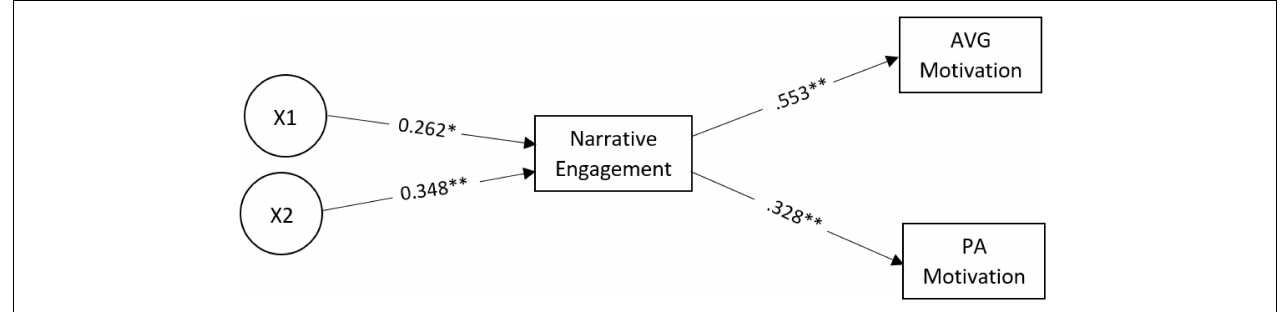
FIGURE 3 | Structural Equation Model for the relation between character body shape and AVG motivation and PA motivation, with narrative engagement as the mediating variable. All paths’ estimates are standardized. X1: the overweight/obese condition in reference to athletic slim condition. X2: the average condition in reference to athletic slim condition. For the sake of simplicity, the direct and indirect paths from the IVs to the DVs as well as the correlations between the DVs are not shown. ∗ p < 0.05; ∗∗ p < 0.001.